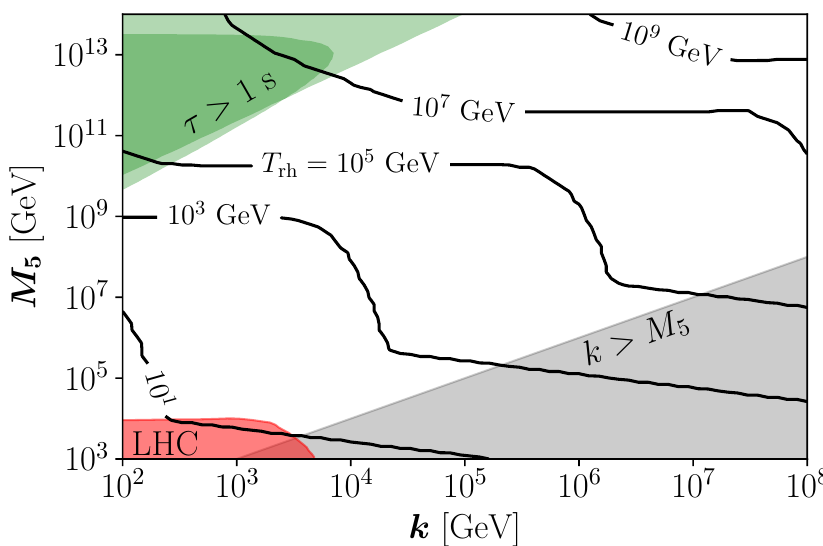
Figure 5 . Contours for the reheating temperature T rh required to reproduce the observed DM abundance, for m DM = 1 MeV. The red-shaded region is in tension with LHC Run-II results from refs. [4, 62]. The gray-shaded region for which k > M 5 is beyond the EFT approach. The green- shaded region corresponds to lifetimes of the lighter KK-mode longer than 1